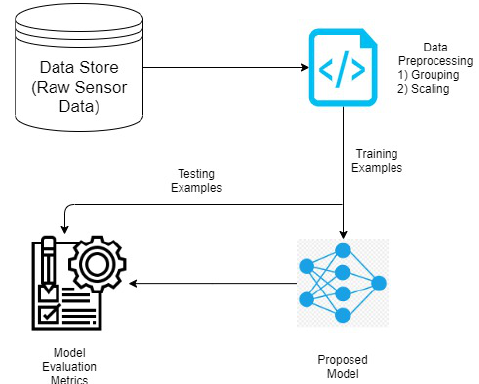
Figure 1. Proposed